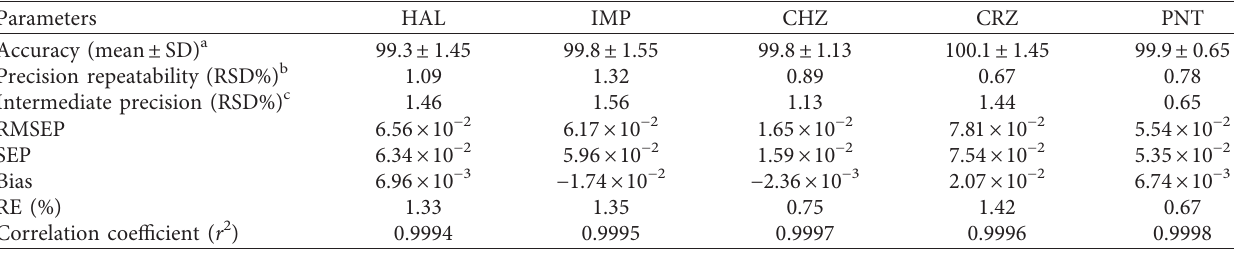
Table 3: Figures of merit of the MCR-ALS regression model for the validation set of CHZ, CRZ, HAL, IMP, and PTN. Parameters